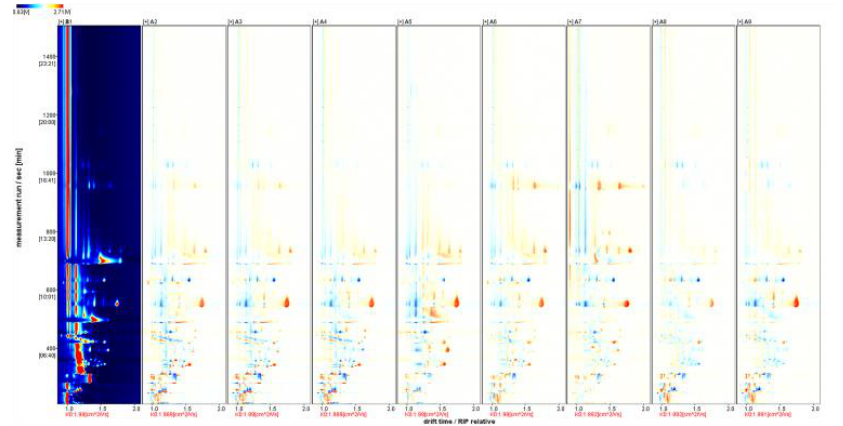
Figure 6. HS-GC-IMS difference spectrum of the sample. Note: From A1 to A9 are ‘Hassan’, ‘Zuoshaner’, ‘Beibinghong’, ‘Zuoyouhong’, ‘Beta’, ‘Shuanghong’, ‘Zijingganlu’, ‘Cabernet Sauvignon’, and ‘Syrah’.